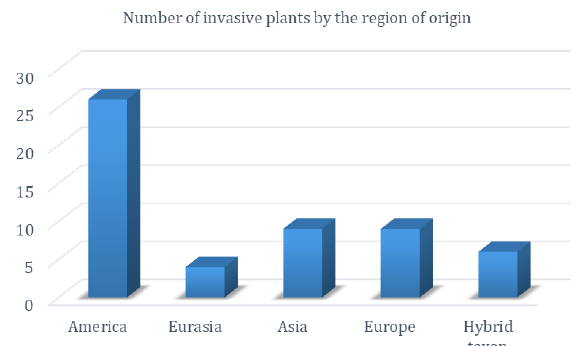
Fig. 1. The invasive and potentially invasive plant species of Belarus by their periods of entry